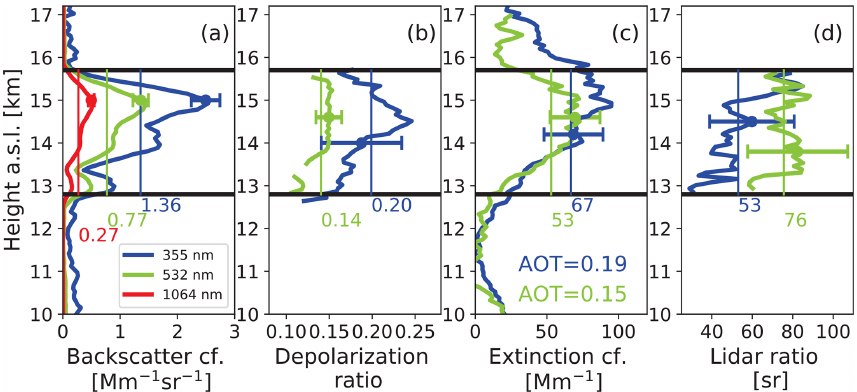
Figure 3. Profiles of smoke optical properties measured with the Polly lidar in the stratosphere over Punta Arenas on 9 January 2020, 03:56–05:40UTC. Base and top heights of the smoke layer are indicated by black horizontal lines. (a) Particle backscatter coefficient at three wavelengths, (b) particle linear depolarization ratio, (c) smoke extinction coefficient and AOT, and (d) smoke extinction-to-backscatter ratio (lidar ratio). Colored vertical lines from layer base to top indicate layer mean values (given also as numbers). Error bars show the estimated uncertainties. In (c) and (d) , Raman signal smoothing with window lengths of 2000–2500m was necessary so that the values around 14–15km height represent best the extinction coefficients and lidar ratios of the 3km deep smoke